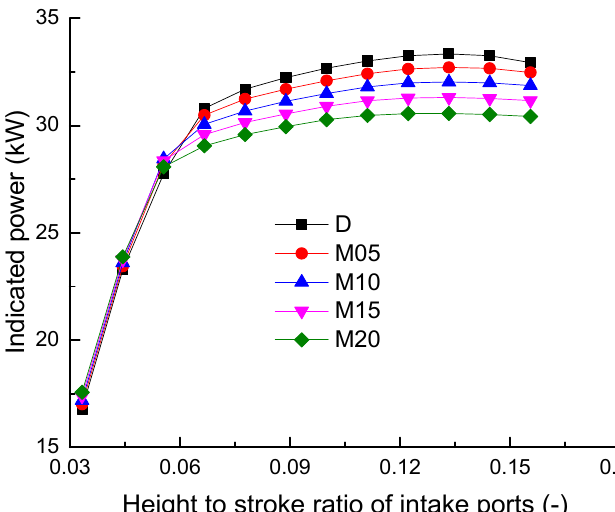
Figure 3. Indicated power under different HSRs of intake ports.